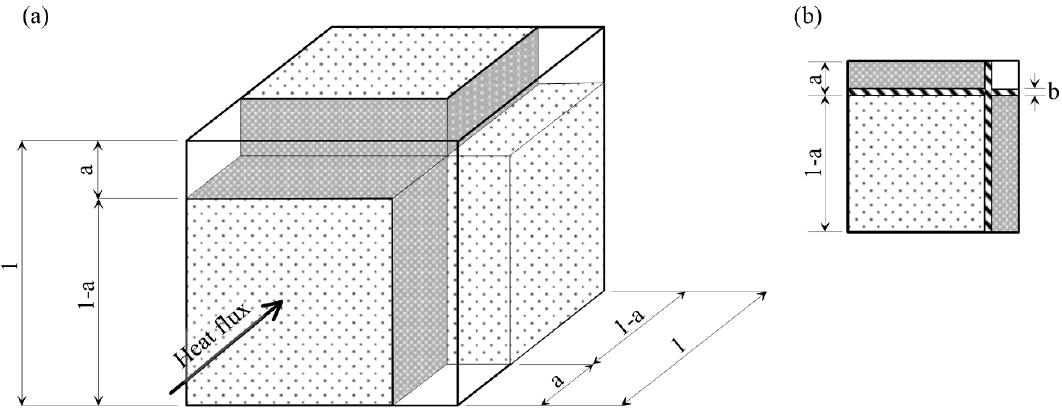
Figure 2: The unit cube considered by Mickley (Farouki, 1981): (a) isometric view; (b) lateral view showing the water layer.